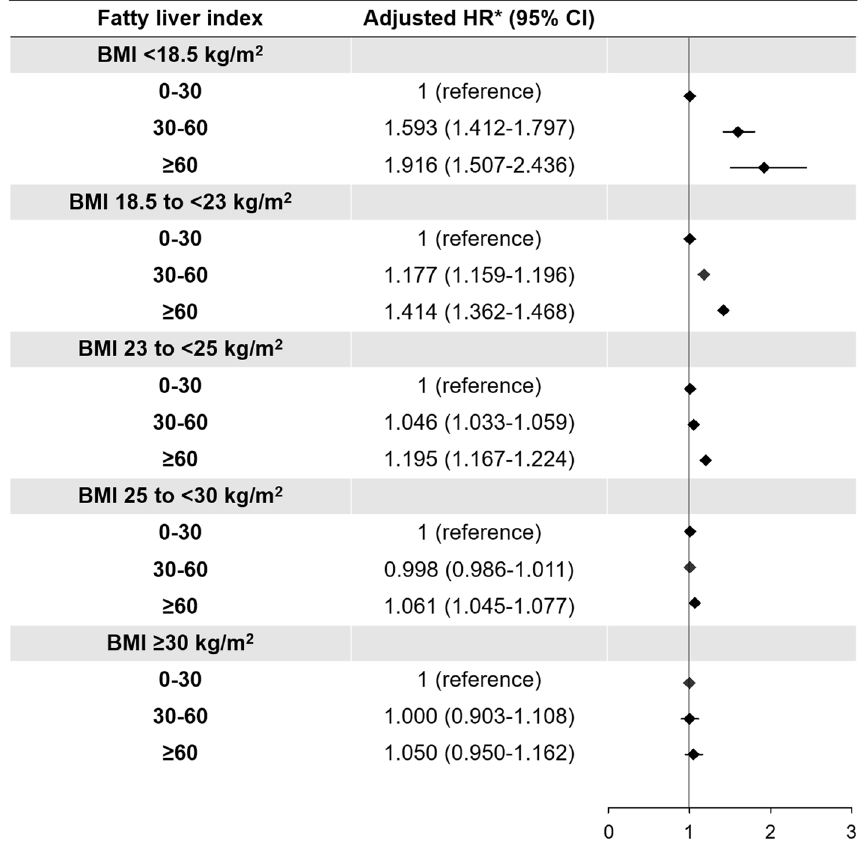
Figure 3. Hazard ratios of the FLI for incident AF in different BMI groups. *Adjusted HR: Model 3 (age, sex, hypertension, diabetes, dyslipidemia, chronic kidney disease, smoking, alcohol consumption, exercise, low income, systolic blood pressure, total cholesterol, and fasting glucose). AF atrial fibrillation, BMI body mass index, CI confidence interval, FLI fatty liver index, HR hazard